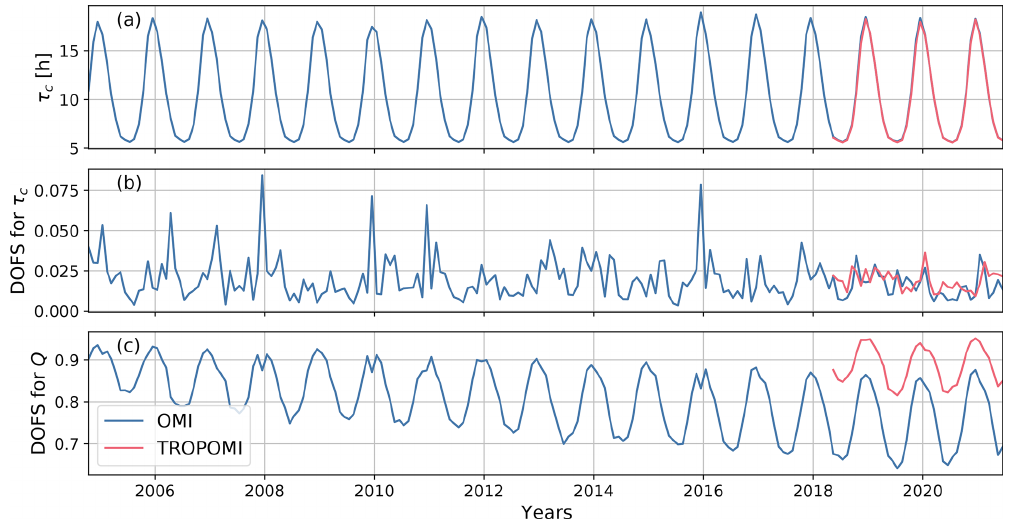
Figure 10. Time series of chemical lifetime (a) , degrees of freedom for signal (DOFS) for chemical lifetime τ c (b) , and DOFS for emission rate Q (c) from the calendar-month-based optimal estimations using OMI (blue) and TROPOMI (red) monthly